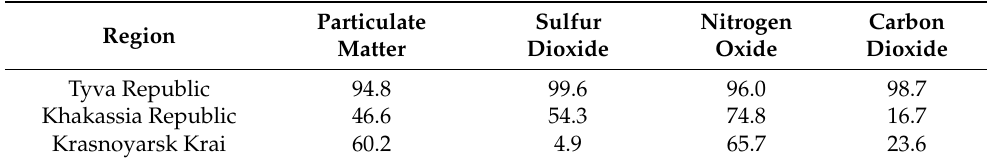
Table 3. Share of pollutant emissions from fuel combustion for electricity and heat generation in total emissions for the region in 2017, %. Source: Rosstat data. Note: the indicator is not calculated after 2017. Particulate Sulfur Region Matter